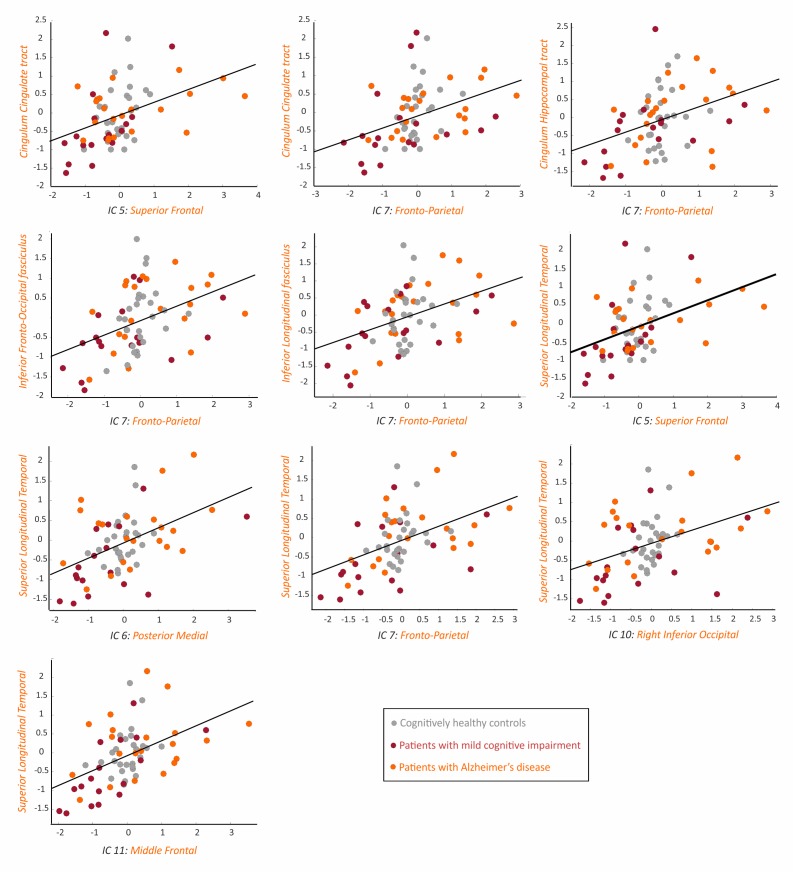
Association between the tau networks and mean diffusivity of white matter tracts.The plots show significant correlations between the SUVRs of different tau networks and mean diffusivity values of white matter tracts in 66 amyloid-β positive subjects with both imaging modalities, after regressing out the effects of age, gender and cognitive impairment, and adjusting for multiple comparisons using FDR corrections (q < 0.05). One AD patient with high mean diffusivity values in white matter tracts was excluded from all plots.Figure 5—source data 1.Association between the tau networks and mean diffusivity of white matter tracts.Values for the tau networks and mean diffusivity of white matter tracts that were significantly correlated with each other, after regressing out the effects of age, sex and presence of cognitive impairment.